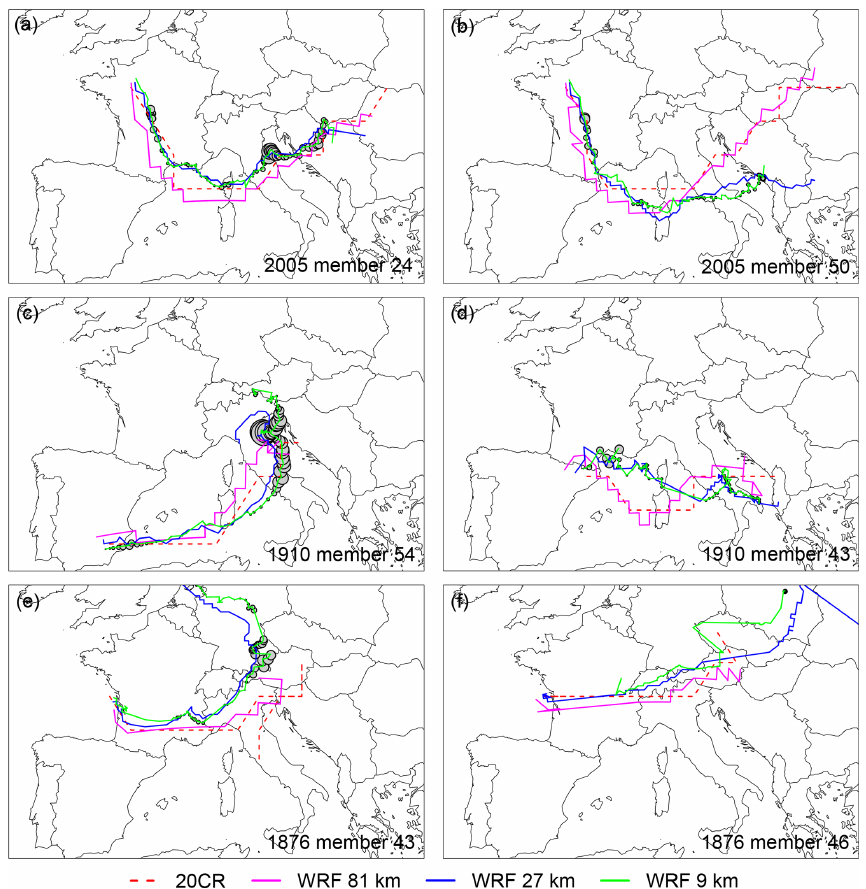
Figure 5. Cyclone tracks, calculated for 500 hPa levels, for the cases of 2005 (a, b) , 1910 (c, d) , 1876 (e, f) , and for members producing maximum (a, c, e) and minimum (b, d, f) precipitation totals over northern Switzerland. The cyclone tracks in 20CR and WRF at 81, 27, and 9km grid sizes are shown in red, magenta, blue, and green, respectively. Filled circles indicate the mean hourly precipitation over northern Switzerland at the time step when the cyclone was centered at the respective grid point in the WRF 3km domain. The circle diameters grow linearly with the precipitation amounts; the largest circle (in c ) represents 6.6mmh − 1